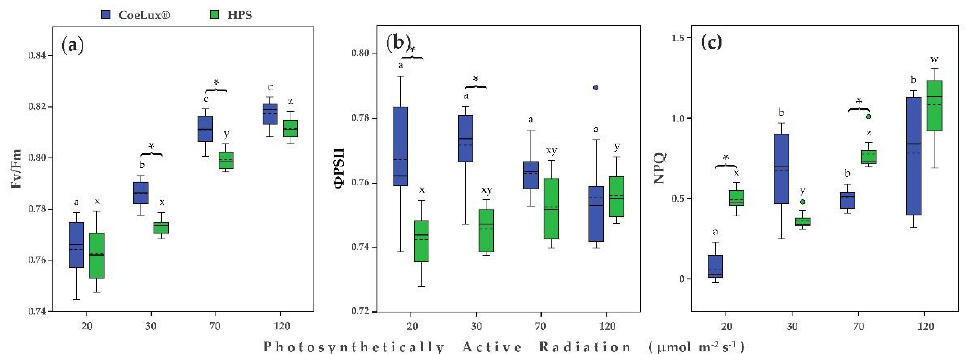
Figure 5. ( a ) Maximum quantum efficiency of PSII photochemistry ( Fv / Fm ), ( b ) PSII operating efficiency in the light ( Φ PSII), and ( c ) non-photochemical quenching (NPQ) for different light intensities. Blue and green bars indicate data of plants grown under the CoeLux ® and the HPS light types, respectively. Black asterisks indicate statistically significant differences ( p < 0.05) between plants grown under the CoeLux ® and the HPS light type within the same light intensity. Letters indicate statistically significant differences ( p < 0.05) between plants grown under different light intensities within the same light type. Vertical boxes represent approximately 50% of the observations and lines extending from each box are the upper and lower 25% of the distribution. Within each box, the solid horizontal line is the median value, whereas the dotted horizontal line is the mean.